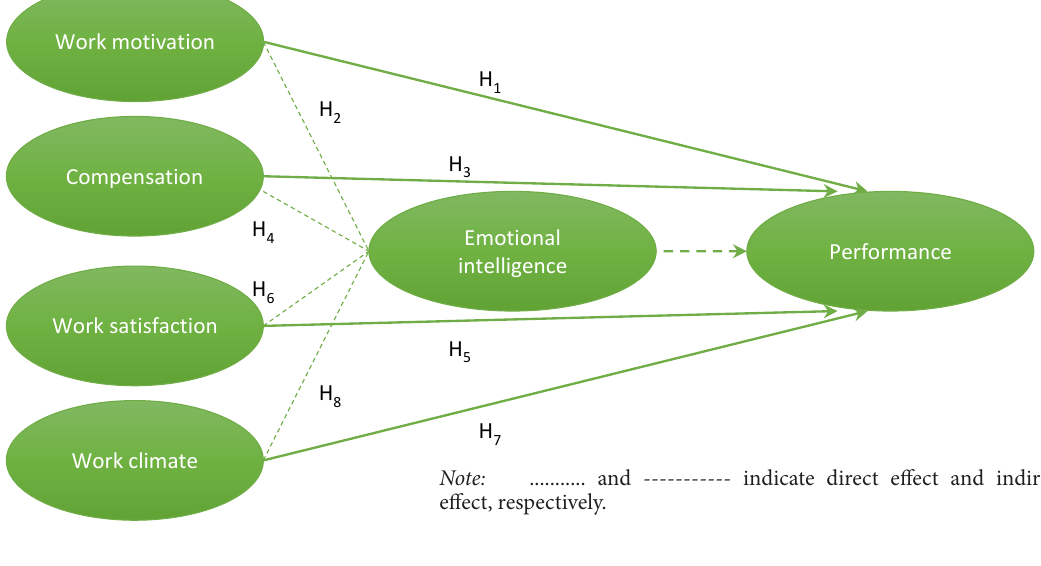
Figure 1. Research’s conceptual